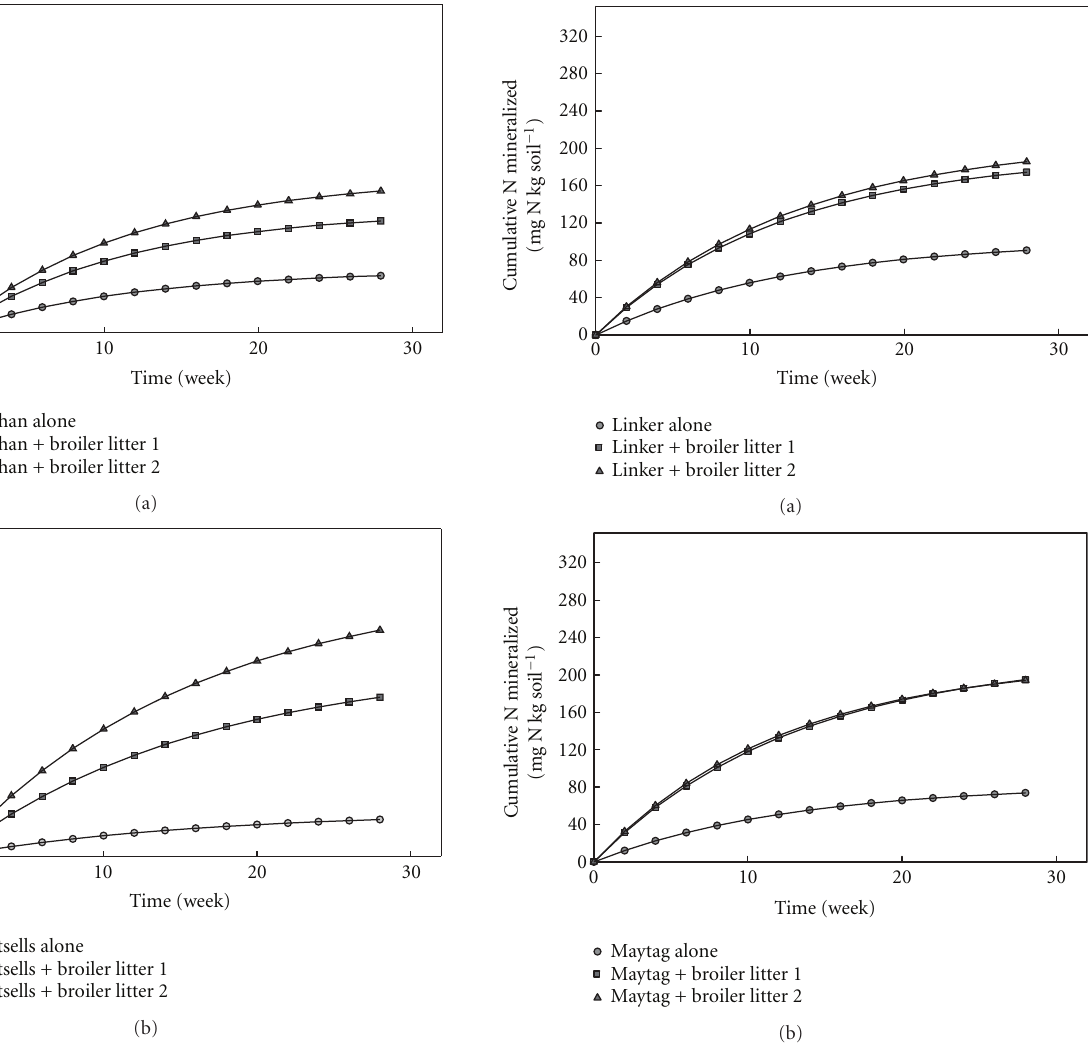
Figure 3: Cumulative organic nitrogen mineralized from Dothan (a) or Hartsells (b) soils amended with broiler litter 1 or 2 and incubated for 28 weeks under aerobic conditions.